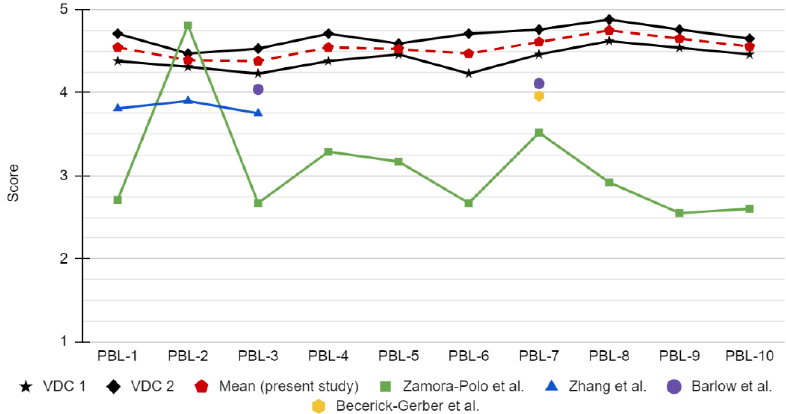
Fig. 6. Survey results on students’ perceptions of the generic competencies development in VDC I and VDC II courses and study